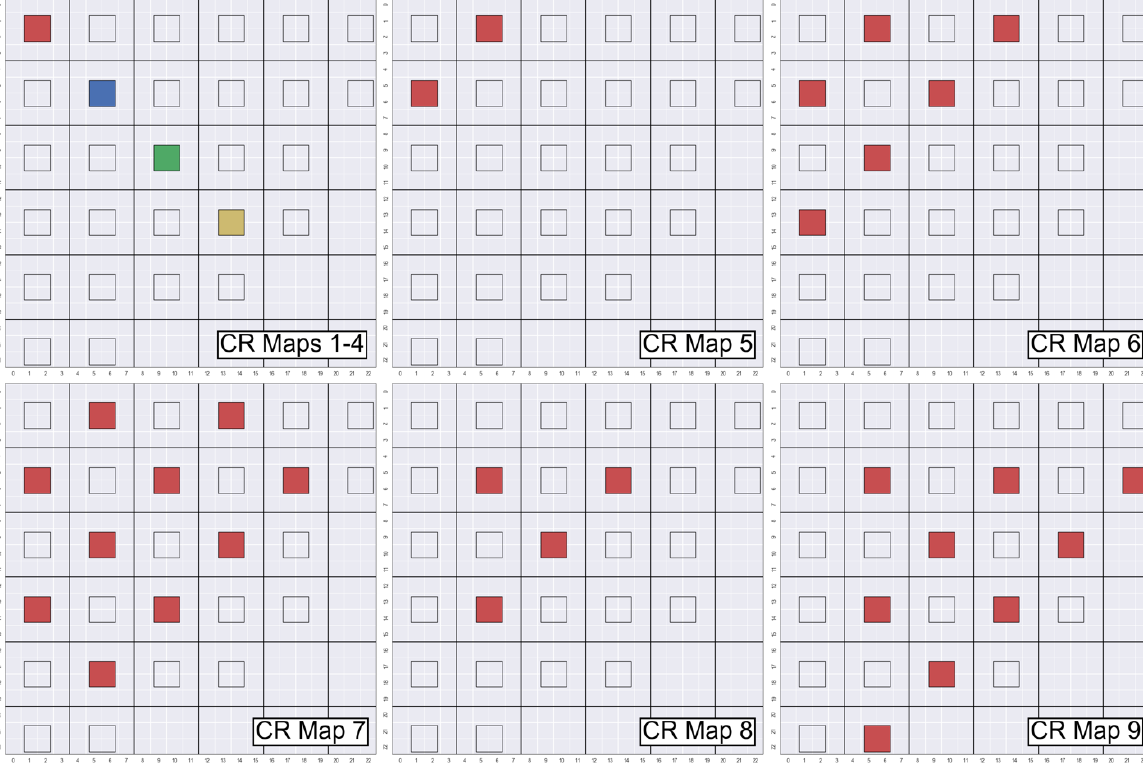
Figure 3. Control rod maps tested. CRM-1 – CRM-4 are shown in the same figure (upper